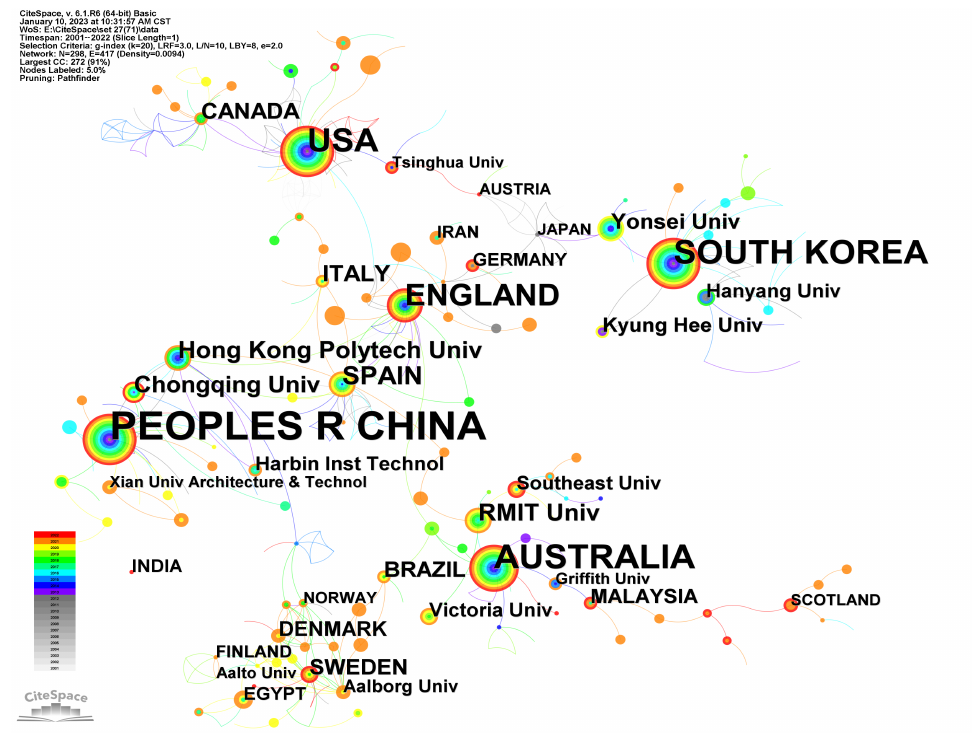
Figure 3. Countries and institutions’ co-occurrence